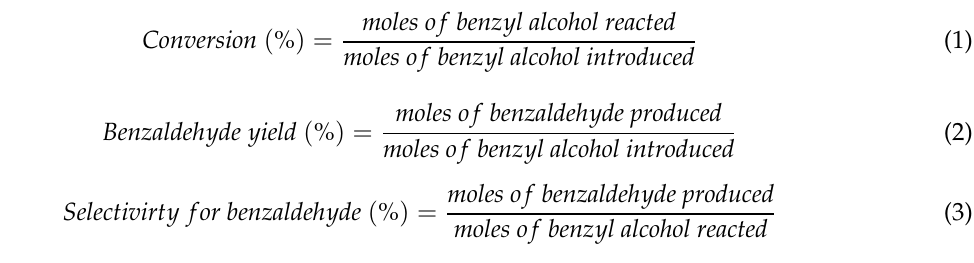
Table 1. The transformations in silent conditions (without ultrasound under argon bubbling stirring)